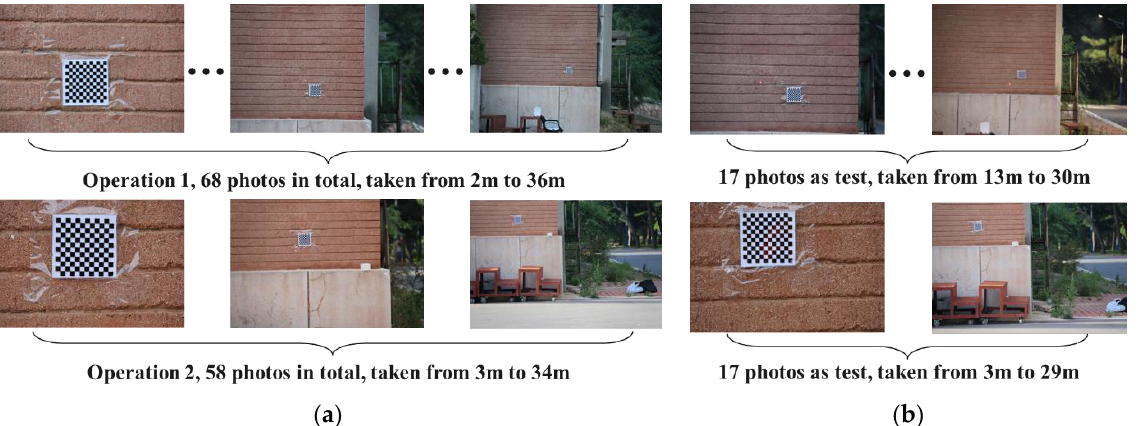
Figure 13. Calibration board for parameter determination: ( a ) training group; ( b ) testing group.